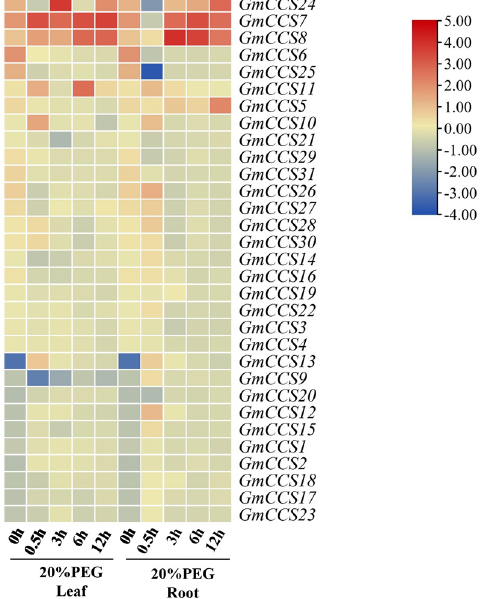
Figure 7. RT-qPCR analysis of GmCCS genes under drought stress. The heatmap was created based on the RT-qPCR results. The transcript abundance is represented by the color bar.